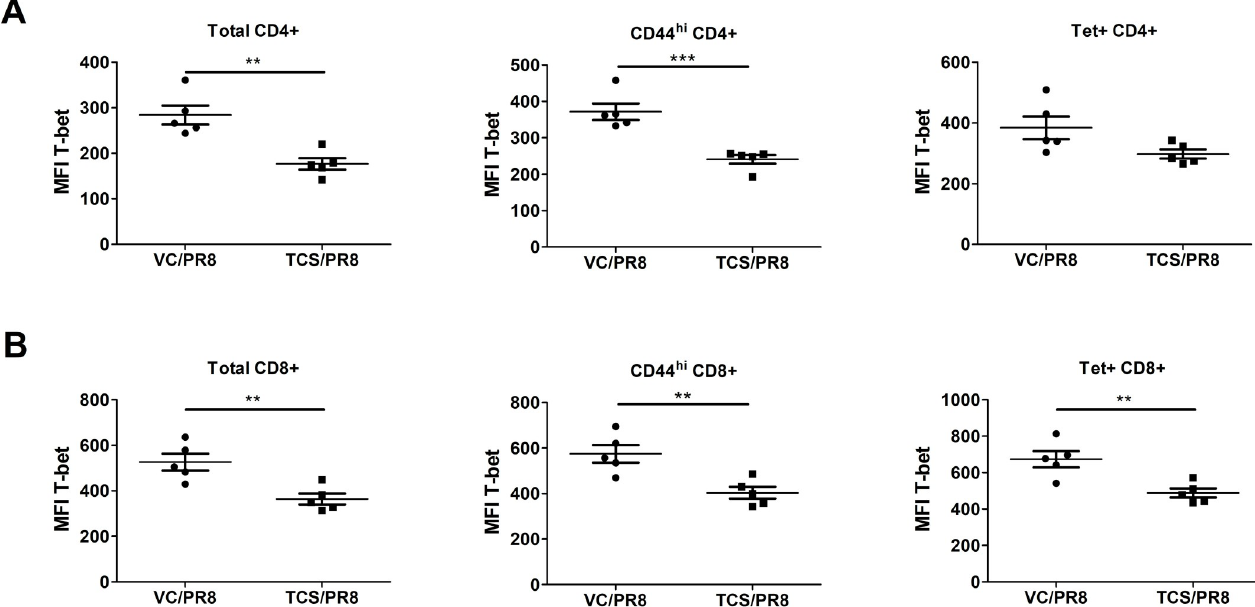
Fig 8. T-bet expression is reduced on a per-cell basis on lung T cells responding to influenza infection in TCS exposed mice. Median fluorescence intensity (MFI) of T-bet expression was measured on total, activated (CD44 hi ), and Tet+ CD4+ (A) and CD8+ (B) T cells isolated from the lungs of mice infected with PR8 at 10 dpi. � s indicate significance values determined using an unpaired student’s t-test between the VC/PR8 and TCS/PR8 groups. �� = p < 0.01, ��� = p < 0.001; n = 5 mice per group.